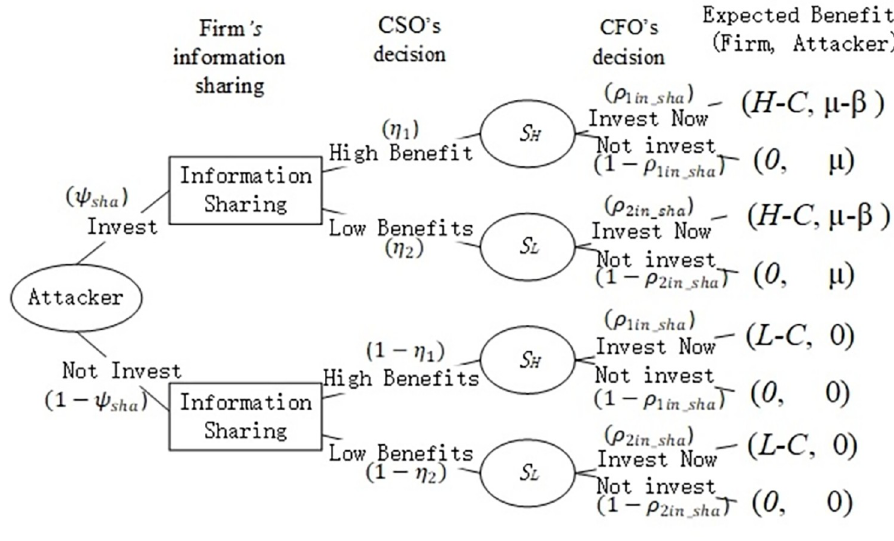
Fig 3. Game tree with information